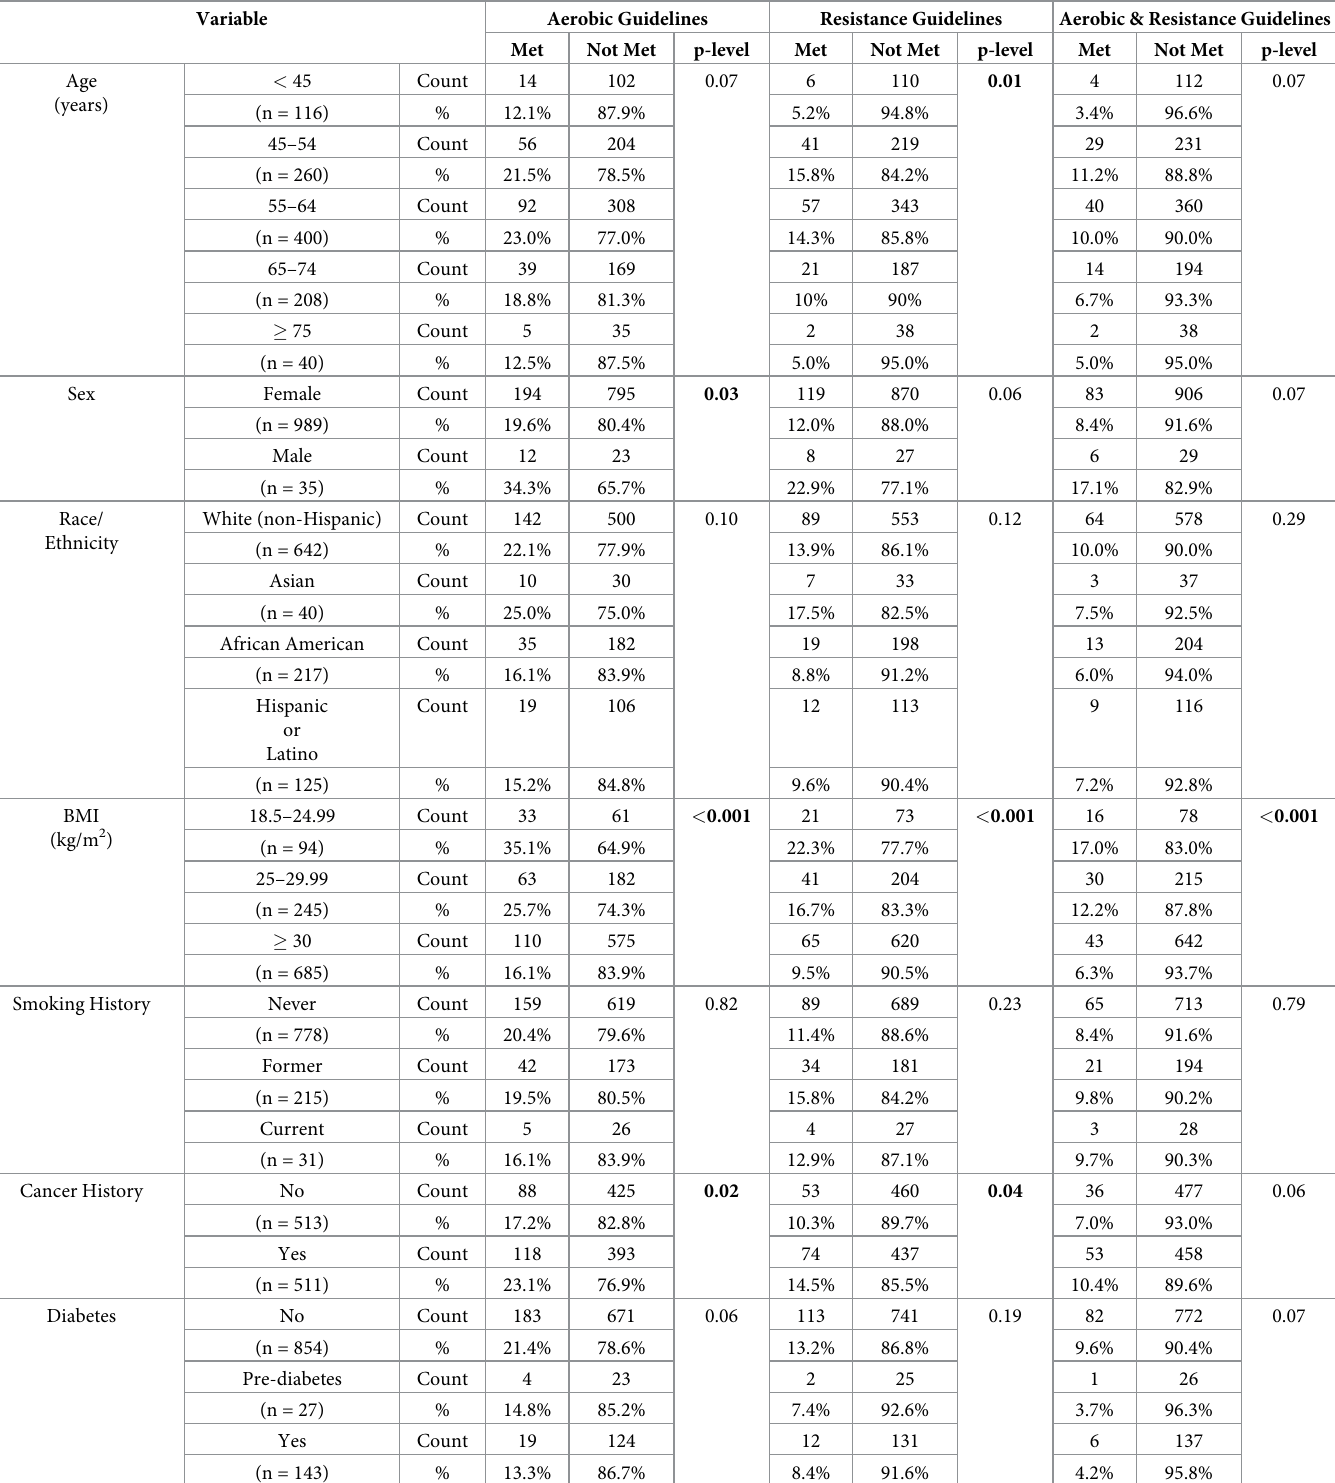
Table 1. Adherence to physical activity guidelines by demographic and clinical